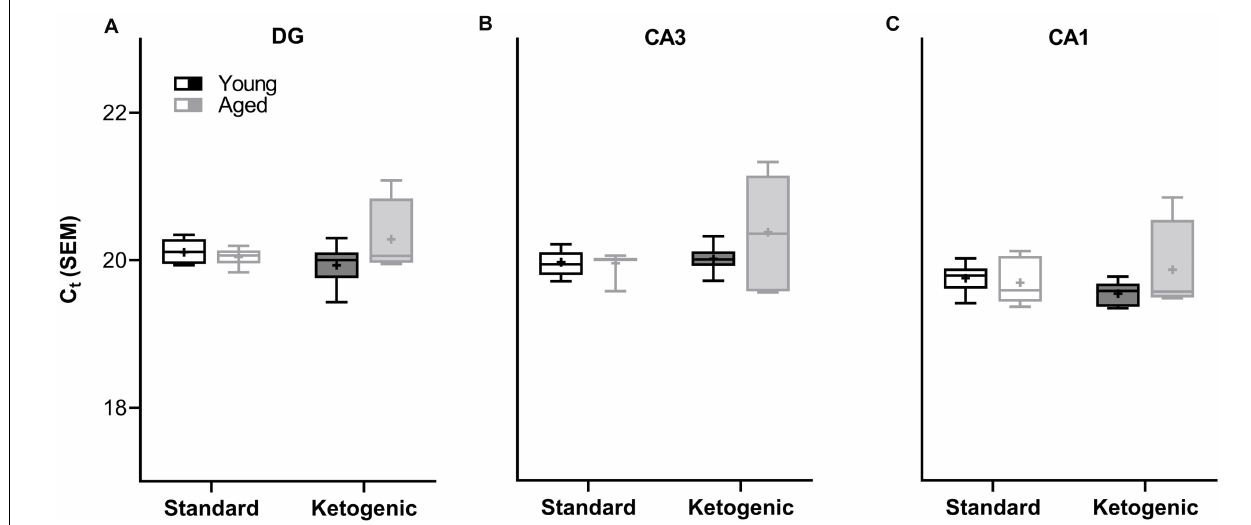
FIGURE 2 | Cycle threshold (C t ) for housekeeping gene RPLP1 across age and diet groups in all hippocampal subregions examined. In the (A) dentate gyrus (DG), (B) CA3, and (C) CA1 subregions, the C t did not vary across age and diet groups, nor was there a significant interaction. Thus, RPLP1 was utilized as a housekeeping gene to normalize the quantification of RNA levels for all other genes of interest. Boxes represent the upper and lower quartiles around the median, the whiskers are the minimum and maximum observed values and + indicates the group